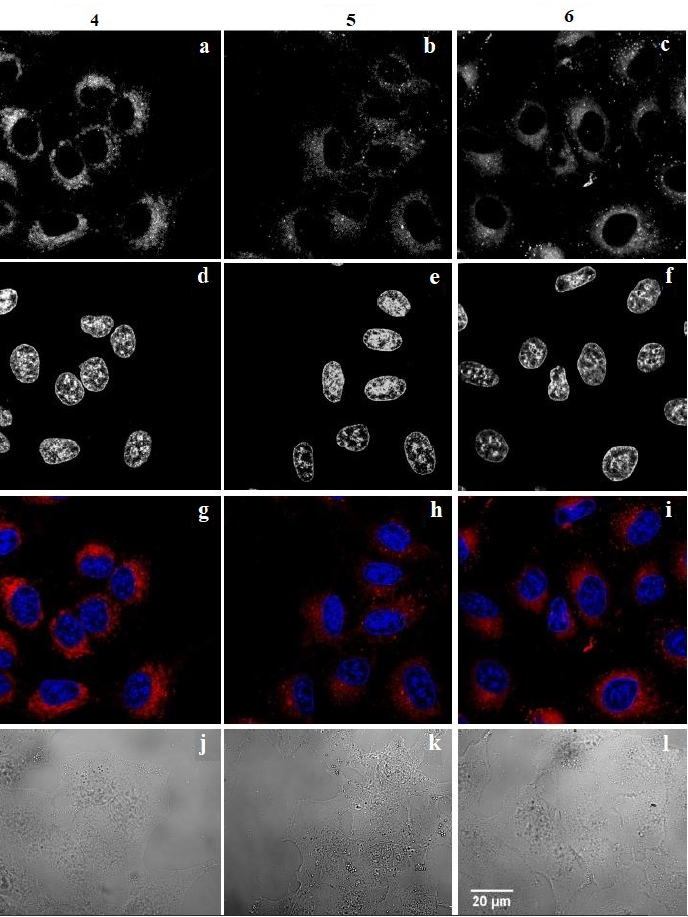
Figure 3. Distribution of 4 , 5, and 6 in A549 cells: ( a – c ) fluorescent images of 4 , 5, and 6; ( d – f ) fluorescent images of Hoechst 33,342 stain; ( g – i ) overlay of fluorescent images (blue—Hoechst 33,342; red— 4 , 5, or 6 ); ( j – l ) cell images in transmitted light.